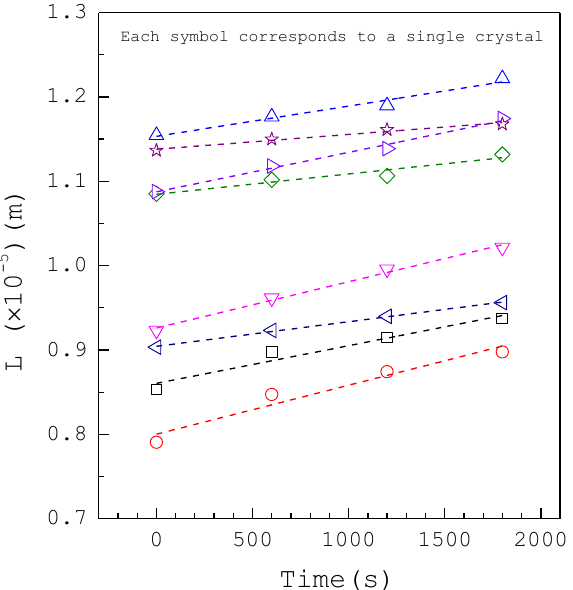
Figure 3. Sizes versus time plots for eight individual crystals for S = 13.65 at 37 ◦ C with 800 ppm magnesium. L represents circular diameter of a crystal. Each line represents the linear regression for a single crystal.